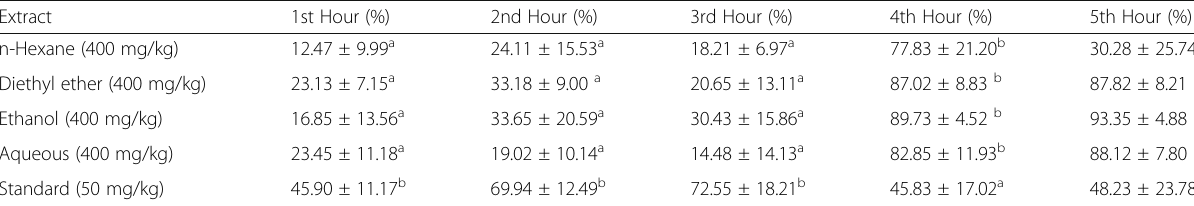
Table 4 The Percentage Inhibition of the Aqueous, Ethanol, Diethyl Ether and n-Hexane Extract of the Root Bark of Feretia Apodanthera on Carrageenan Induced Inflammation Extract